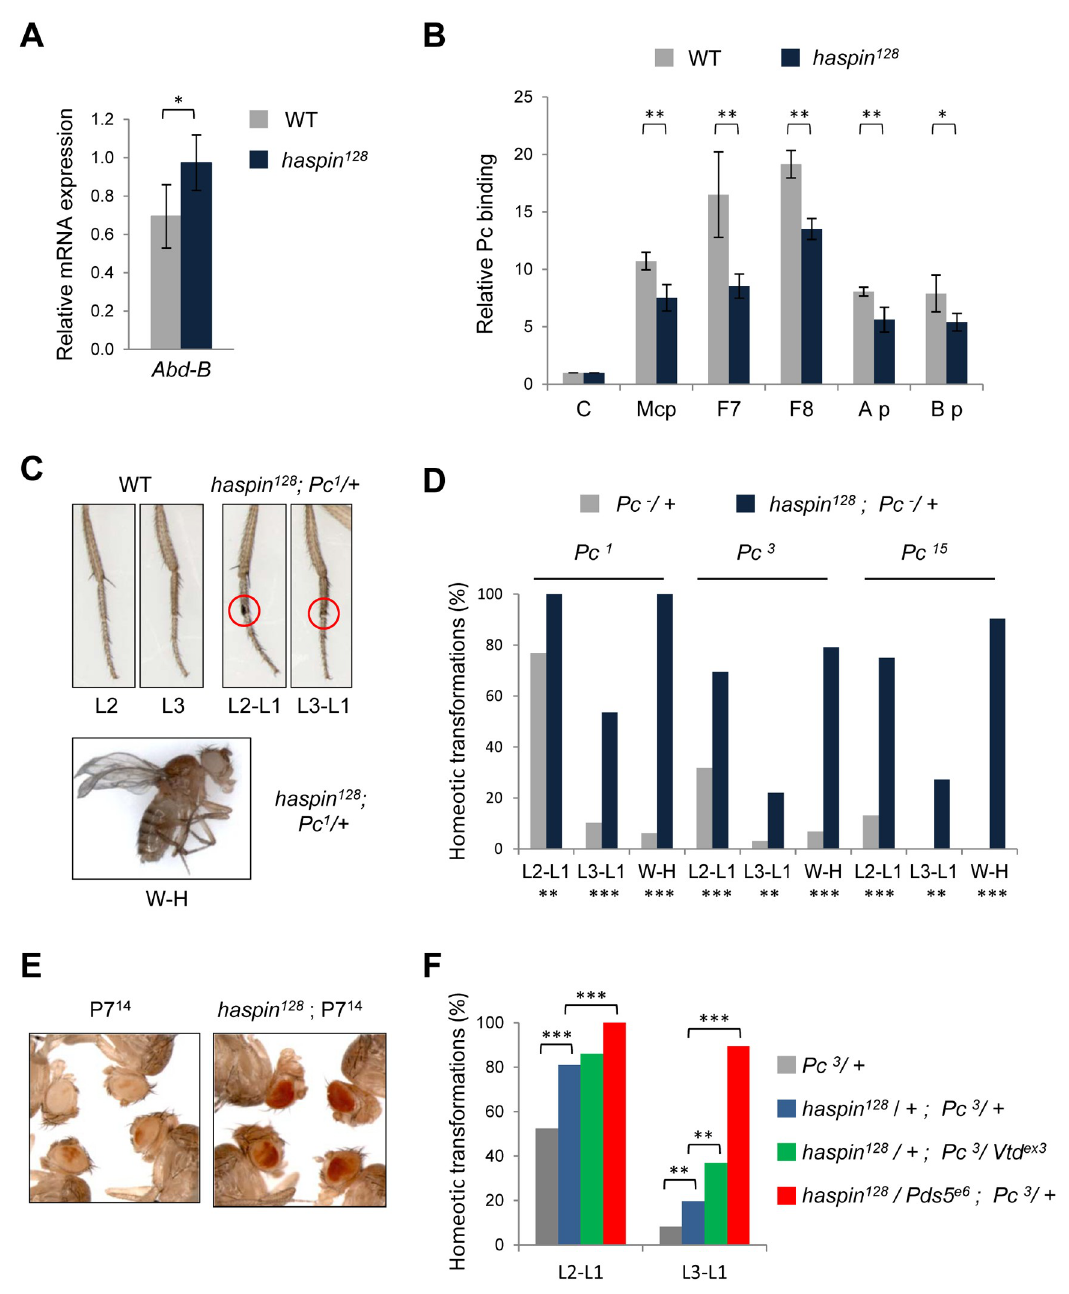
Fig 5. Haspin is required for Polycomb-dependent homeotic gene silencing. A) Abdominal-B transcriptional levels normalized to Actin5C in wild-type or haspin 128 mutant Drosophila larval brains. n = 4, means and s.d. are shown. B) ChIP-qPCR using an antibody against Polycomb and primers for pointed as a control negative region, Mcp , Fab7 and Fab8 regulatory elements and Abd-B promoters A and B. Average enrichments (normalized to the input sample) are plotted as the ratio of precipitated DNA in either wild-type or haspin 128 Drosophila larval brains relative to the control negative region. n = 3, means and s.e.m. are shown. C) Representative examples of homeotic transformations observed: second to first leg (L2-L1), third to first leg (L3-L1) and wing to haltere (W-H). A red circle marks sex combs that appear in the second and third leg of male flies. D) Frequencies of homeotic transformations in flies heterozygous for Pc 1 , Pc 3 or Pc 15 mutations in either wild-type or homozygous haspin 128 mutant backgrounds. n = 3, over 20 individuals scored. E) Eye color of representative flies of a transgenic line P7 14 containing a homozygous PRE- miniwhite in a wild-type or haspin 128 mutant background (n = 3). F) Frequencies of homeotic transformations in flies heterozygous for Pc 3 mutation in either wild-type or combinations of heterozygous mutant backgrounds for haspin 128 and cohesin complex components. n = 4, over 50 individuals scored. Statistical significance ( � p < 0.05, �� p < 0.01 and ��� p < 0.001) was determined by Student’s t -test (A and B) or z -test (D and F).